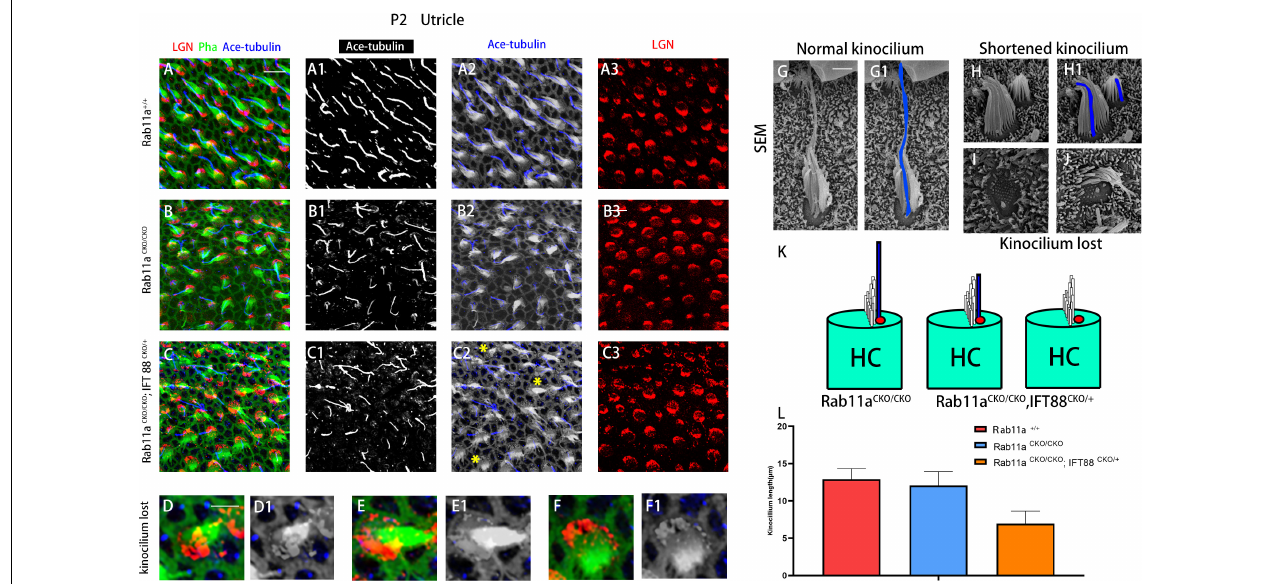
FIGURE 2 | Kinocilia were shortened or lost in Rab11a IFT mutant mice. (A–A3) In P2 wild-type mice, kinocilia were located on one side of the hair cells, marking the planar cell polarity of single hair cells. (B–B3) The length and number of kinocilia were generally normal in Rab11a mutant utricles. (C–C3) Kinocilia were lost or shortened in Rab11a CKO / CKO ; IFT88 CKO / + utricle (yellow asterisks). (D–F1) Enlarged images of hair cell marked with yellow arrowheads in (C2) . (G,G1) Scanning electron microscopy image of a normal hair cell. The kinocilia are outlined (blue). (H,H1) Shortened kinocilia were found in the hair cells of Rab11a mutant utricular macules. (I,J) The whole kinocilia were lost in the hair cells of Rab11a mutant utricular macules. (K) The schematic view of kinocilium shortened or lost in Rab11a CKO / CKO ; IFT88 CKO / + utricle. (L) The average kinocilium length of control, Rab11a CKO / CKO , Rab11a CKO / CKO ; IFT88 CKO / + utricle. The kinocilium length of control, single and double knockout hair cells were 12.90 ± 1.43, 12.07 ± 1.87, and 6.95 ± 1.67 µ m, respectively. In (A–F) , for all primary panels, hair cell stereociliary bundles were marked with phalloidin (green), kinocilium were labeled with acetylated tubulin (blue), and intrinsic cell polarity was labeled with LGN (red). Scale bars: 10 µ m (A–C3) , 5 µ m (D–F1) , 1 µ m (G–J)